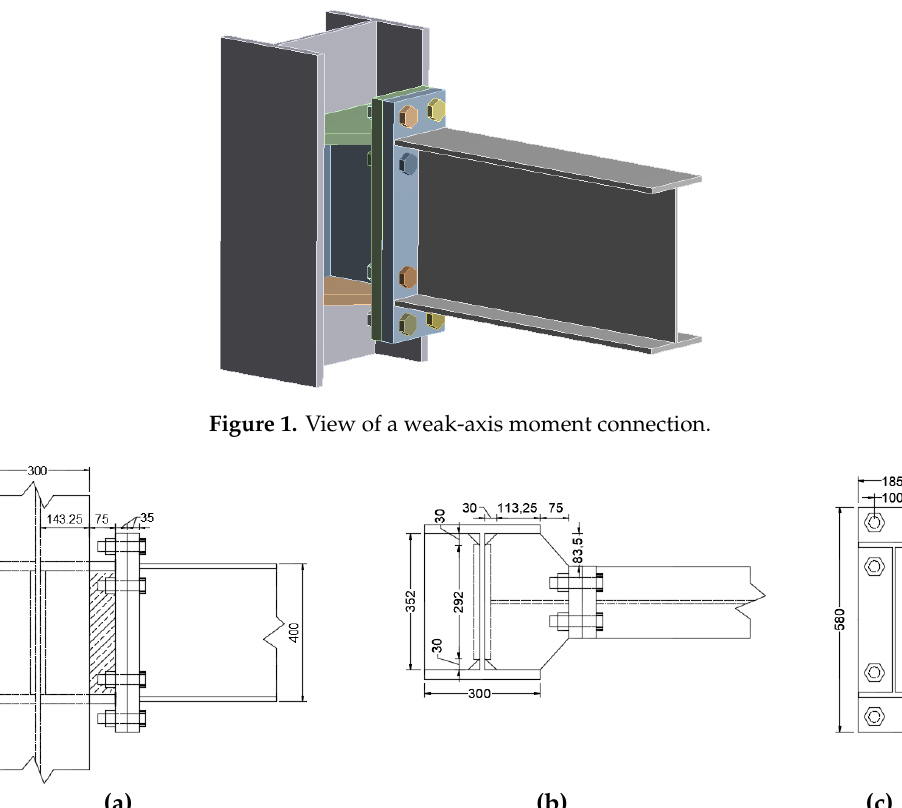
Figure 2. ( a ) Elevation view of moment connection, ( b ) plan view of moment connection, and ( c ) details of the distance between end-plate bolts (all dimensions in mm).